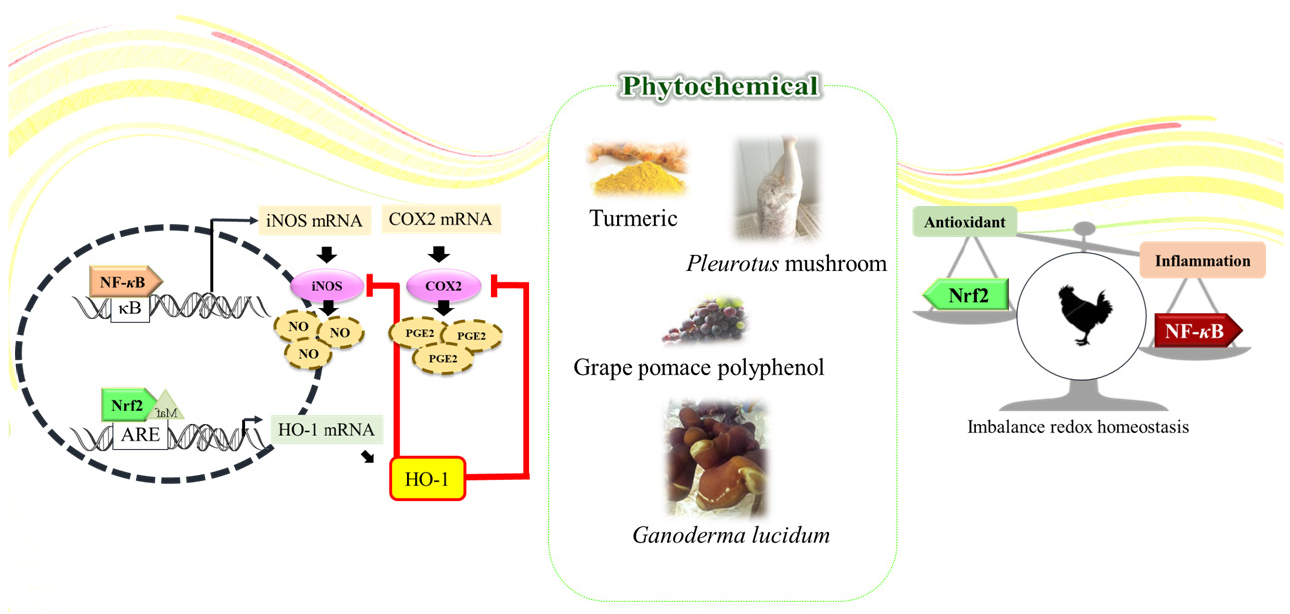
Figure 3. Potential crosstalk between oxidative stress and inflammation through phytochemicals in